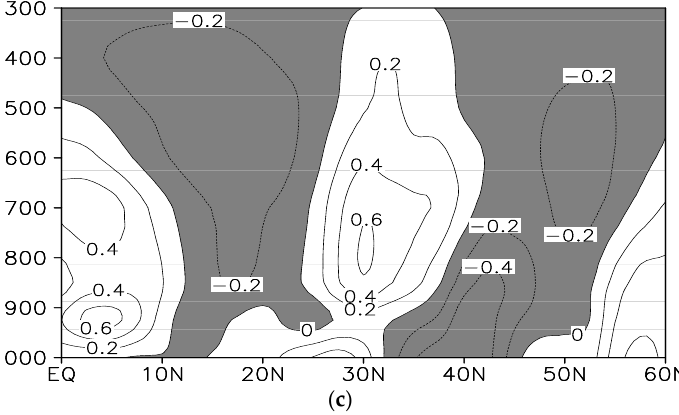
Figure 7. Composite differences of latitude–pressure cross section of ( a ) vertical velocity (contours) and meridional circulations (vectors); ( b ) air temperature; and ( c ) specific humidity averaged along 100°E–180°E between 2014 and climatological mean in August. The values of vertical velocity are multiplied by −100. Shaded areas denote negative values. Contour intervals are 0.3 −2 hPa·s −1 for vertical velocity, 0.1 °C for air temperature, and 0.2 g·kg −1 for specific humidity, respectively. In the anomaly field for the 850 hPa relative vorticity during August 2014, many regions in the tropical and subtropical western North Pacific exhibited negative anomalies (Figure 8). A smaller value in 850 hPa relative vorticity indicates a corresponding strengthening of clockwise circulations.